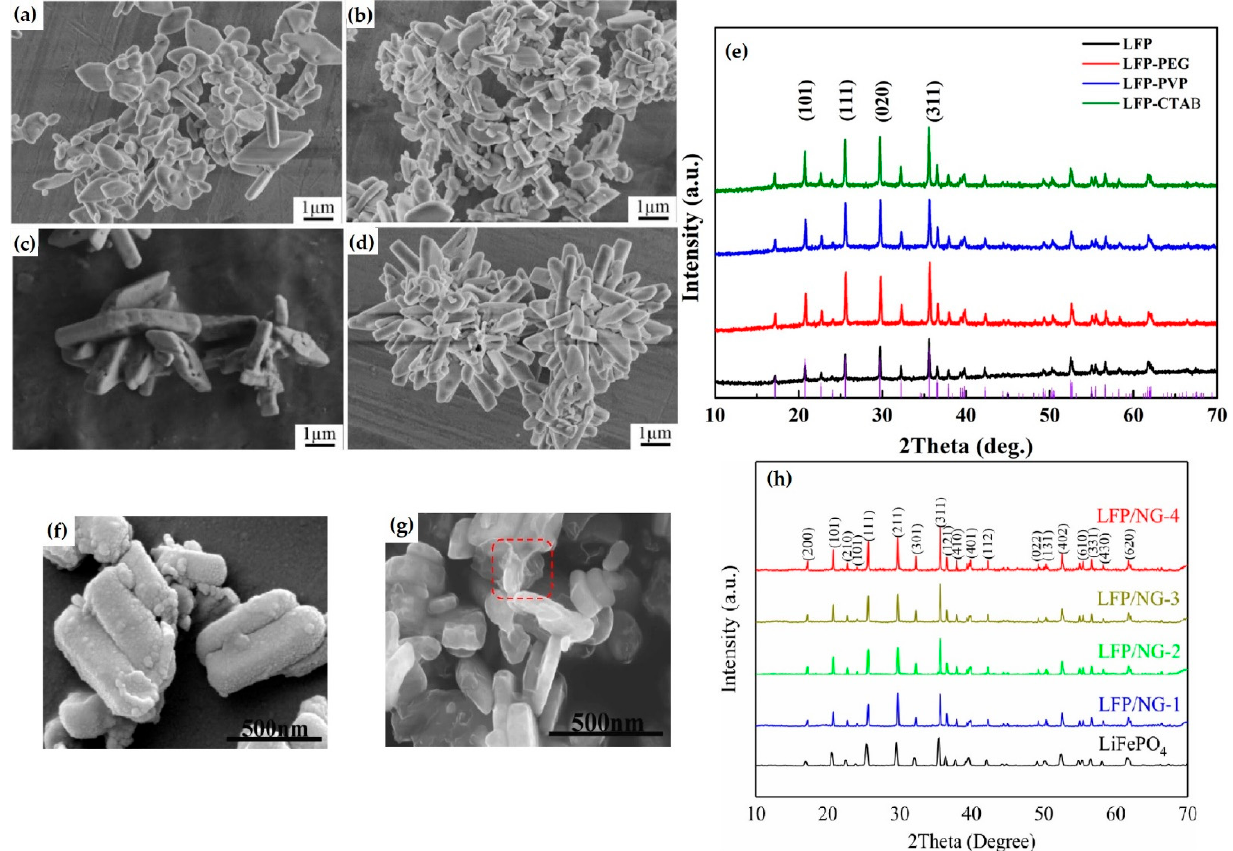
Figure 4. SEM images of LiFePO 4 ( a ), LiFePO 4 with PEG-assisted ( b ), PVP-assisted ( c ) and CTAB- assisted ( d ) and their XRD patterns ( e ) [58]. SEM images of LiFePO 4 ( f ) and LiFePO 4 with N-doping ( g ) and their XRD patterns ( h ) [59] (Note: NG stands for the ratio of melamine to graphene oxide. NG-1, NG-2, NG-3 and NG-4 stand for 20:1, 15:1, 10:1 and 5:1, respectively). Adapted with permis- sion from Ref [58]. 2021, Springer Nature and Ref [59] . 2021, Elsevier.